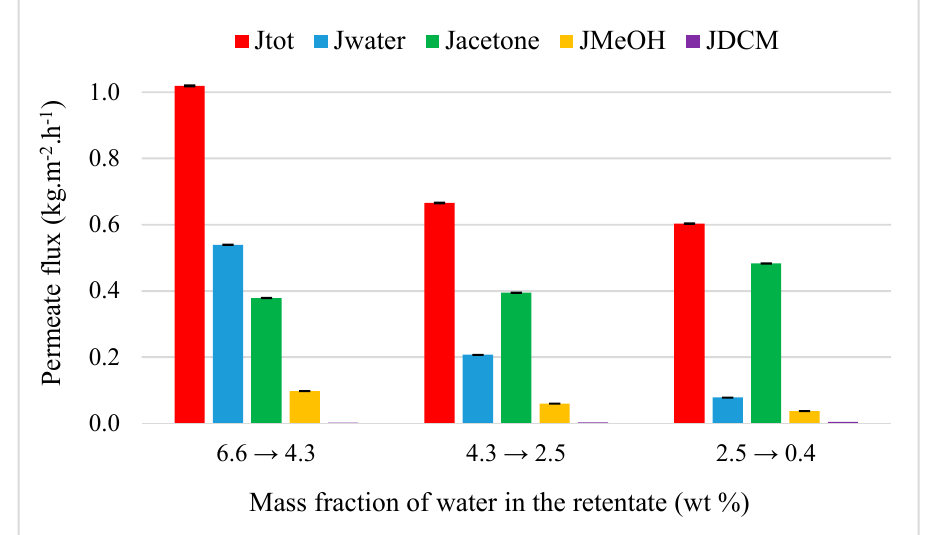
Figure 10. Evolution of flux as the function of the inlet water composition from a quaternary acetone-water–MeOH-DCM mixture (89.4/6.6/2.2/1.8 wt%) through M1 at 50 °C.